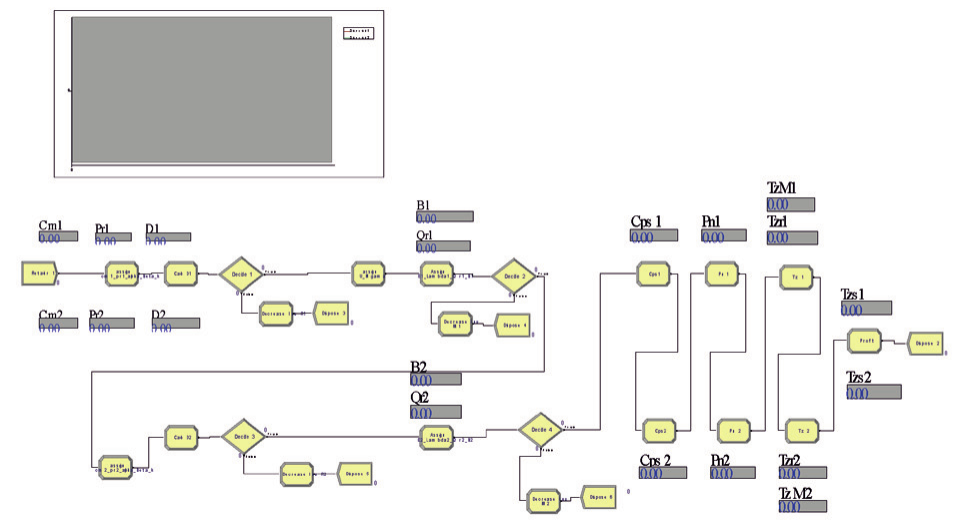
Fig. 3. Arena-based retailer leadership, a simulated